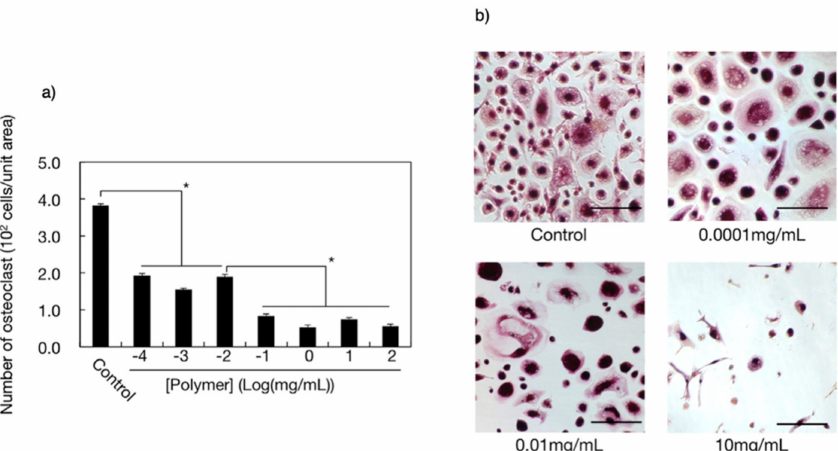
Figure 7. ( a ) Densities of adherent osteoclasts on bovine bone slices after incubation with poly(ethylene sodium phosphate) (PEP · Na) for 24 h ( n = 4). Student’s t-test was performed on the samples to test the statistical significance of di ff erences (* p < 0.005). ( b ) Optical micrographs of adherent osteoclasts on a bovine bone slice after cultivation with PEP · Na for 24 h. Scale bars represent 100 µ m.